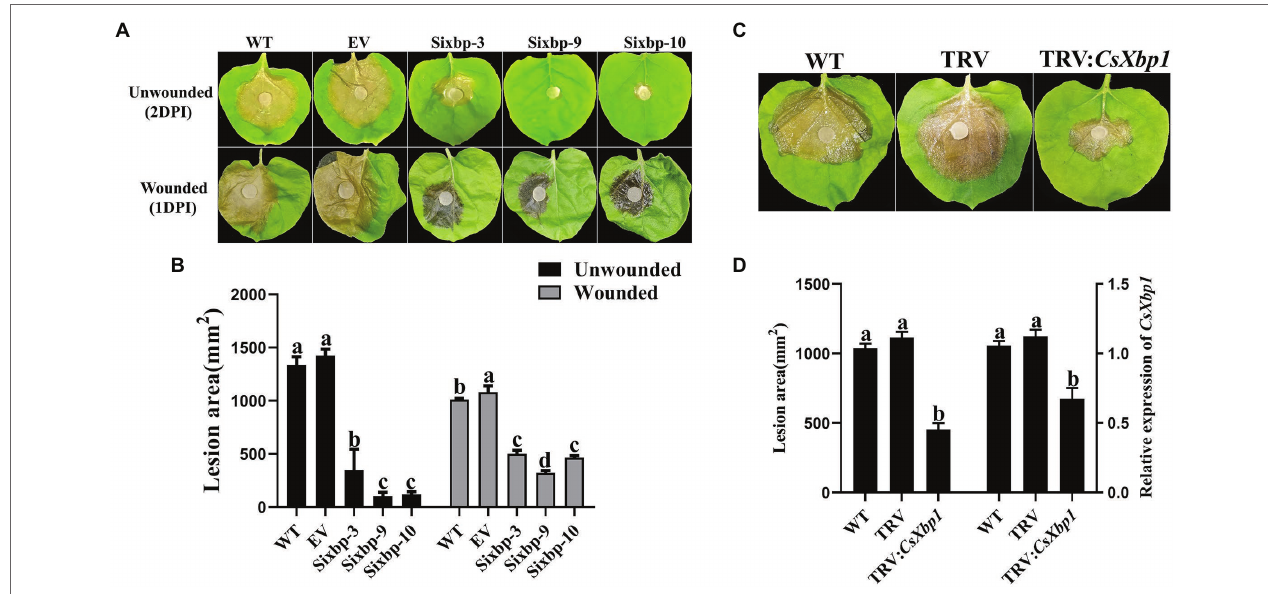
FIGURE 6 | The measurement of pathogenicity in WT, EV, and RNAi strains. (A) Ciboria shiraiana infections of unwounded and wounded N. benthamiana leaves. (B) The lesion areas were measured using ImageJ software. (C) At 14-days-after agroinfiltration of Agrobacterium tumefaciens carrying the TRV- CsXbp1 plasmid, the lesion areas were recorded. (D) The lesion areas were measured and evaluated the expression level of CsXbp1 in WT and agroinfiltrated plants. Different letters above bars represent significant differences ( p < 0.05) as determined using a one-way Duncan’s test. The experiment was repeated three times, and each strain was investigated with three N. benthamiana leaves each